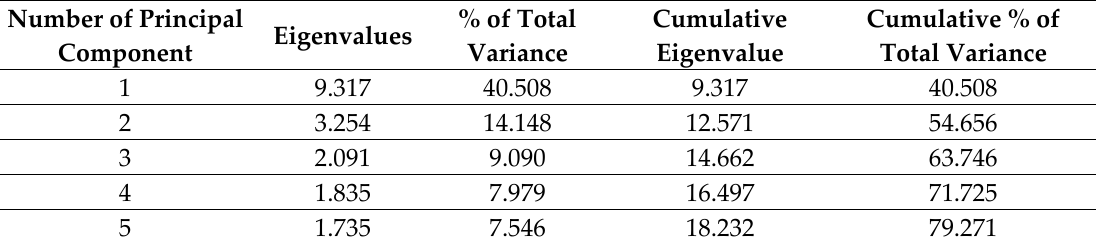
Table 3. The results of the PCA analysis for leachates from closed